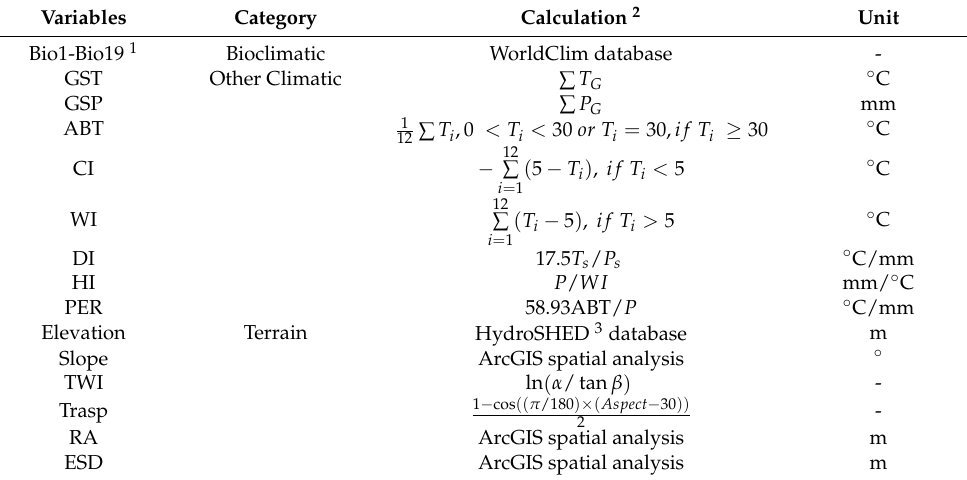
Table 3. Environment variables used in Maxent